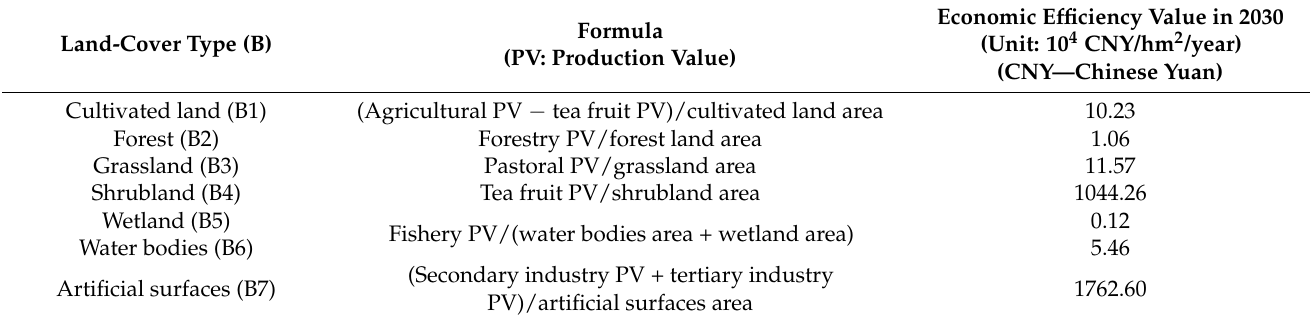
Table 3. Economic efficiency factors of each land-cover type in Hangzhou.